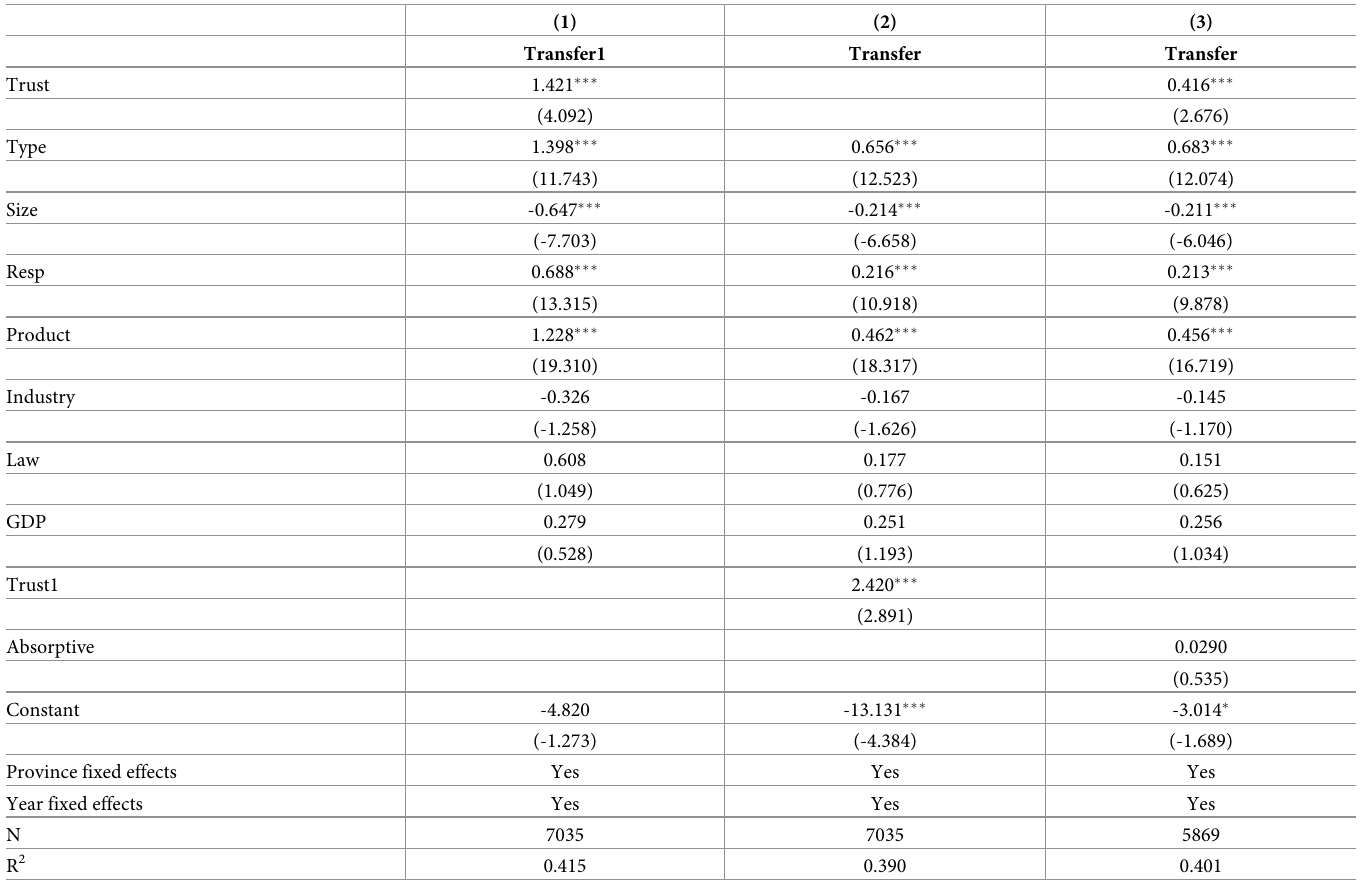
Table 4. Robustness